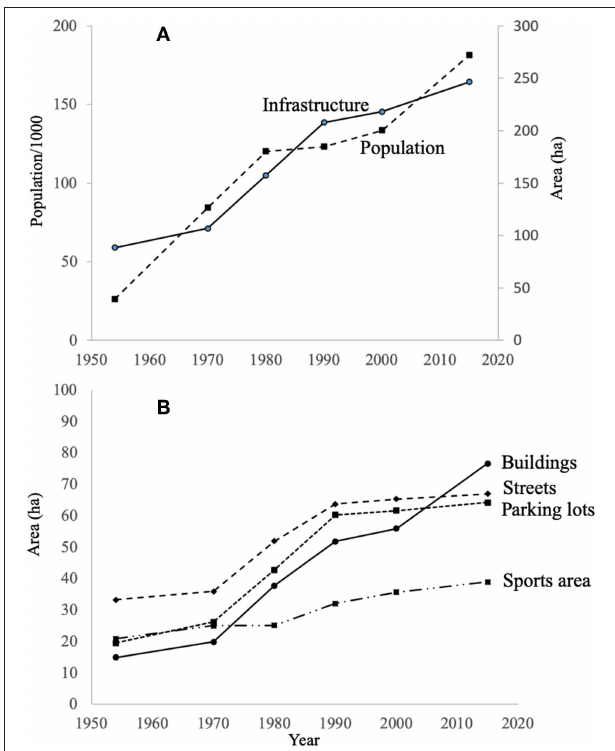
FIGURE 2 | Infrastructure and population of the UNAM campus (A) and different types of urban infrastructure growth (B) from 1954 to 2015. Population numbers are in thousands and refers to the people (academics, students, and workers).